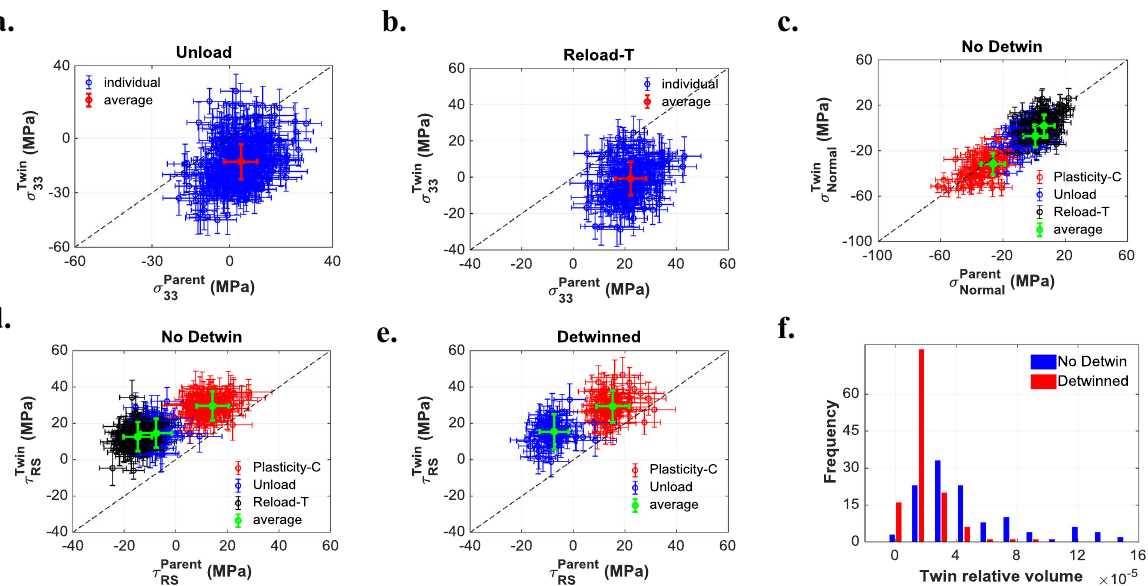
Fig. 3 Annihilation of twins. Measured σ 33 in twins as a function of measured σ 33 in the corresponding parents for ( a ) Unload and ( b ) Reload-T steps. ( c ) Measured stress normal to the twin habit plane for twins that did not annihilate. Measured resolved shear stress on the twin habit plane in the twinning direction for ( d ) twins that did not annihilate and ( e ) twins that detwinned. ( f ) The measured relative volumes of the twins at Plasticity-C. The circles with their crosses represent the stress values and their corresponding error